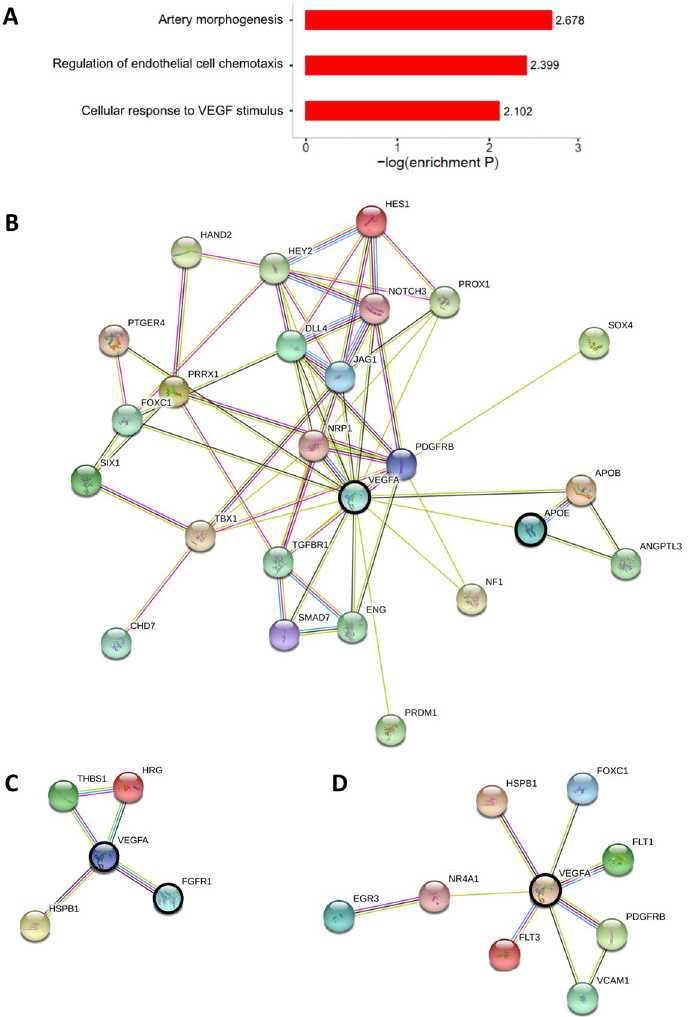
Fig 5. Angiogenesis pathways differentially expressed between Black and White individuals and the network structure of interactions between their leading-edge gene products. (A) Convergence of DEGs between Black and White individuals on angiogenic functions. Shown are enriched Gene Ontology (GO) annotations among DEGs between Black and White individuals, as measured in whole blood RNAseq. (B-D) Relationships between the protein products of genes driving the up-regulation of (B) artery morphogenesis, (C) regulation of endothelial cell chemotaxis, and (D) cellular response to VEGF stimulus in Black, as compared to White individuals. Shown is the PPI network structure of products of leading-edge genes, namely those driving pathway-level differential expression between Black and White individuals. Nodes represent proteins, while their interactions are denoted by color-coded edges: Magenta, experimentally determined interactions; cyan, manually curated interactions; green, interactions reported in PubMed abstracts; black, co-expression; and blue, protein homology. VEGFA, APOE, and FGFR1 are highlighted by a bold black circle because of their network centrality and implication in diseases of racial